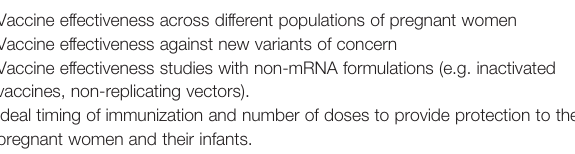
TABLE 4 | Consensus on priorities for future research related to immunogenicity of immunization against SARS-CoV-2 in pregnancy. Antibody immune response Immunogenicity in pregnant women of all licensed COVID-19 vaccines. Vaccine-induced antibody transfer kinetics across all pregnancy trimesters. The impact of booster COVID-19 immunization (following completion of 2 doses of primary immunization) in pregnancy. Co-administration with other vaccines given in pregnancy and immune response to COVID-19 vaccines Number of doses and timing of immunization Optimal timing of immunization during pregnancy and the ideal time interval between the two doses. Immune response of heterologous schedules with different number of vaccine does Induction of antibodies in breast milk Protection against SARS-CoV-2 in breastfeeding infants of vaccinated women and it ’ s duration. Correlate(s) of protection of vaccine-induced anti-SARS-CoV-2 antibodies in breast milk. Duration of humoral protection provided via breastfeeding. Studies on lactating women vaccinated with non-mRNA-based COVID-19 vaccines. Cellular immune response Magnitude and diversity of cellular immune responses (adaptive and innate) after immunization at different time point during pregnancy.